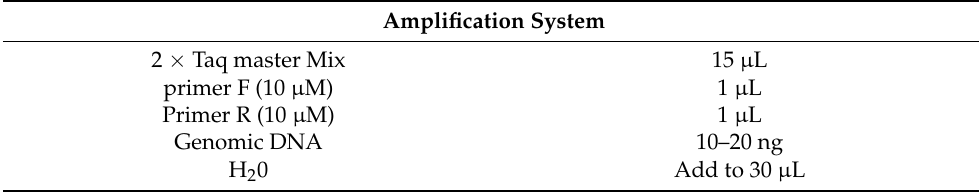
Table 1. DNA amplification system of the microbial community